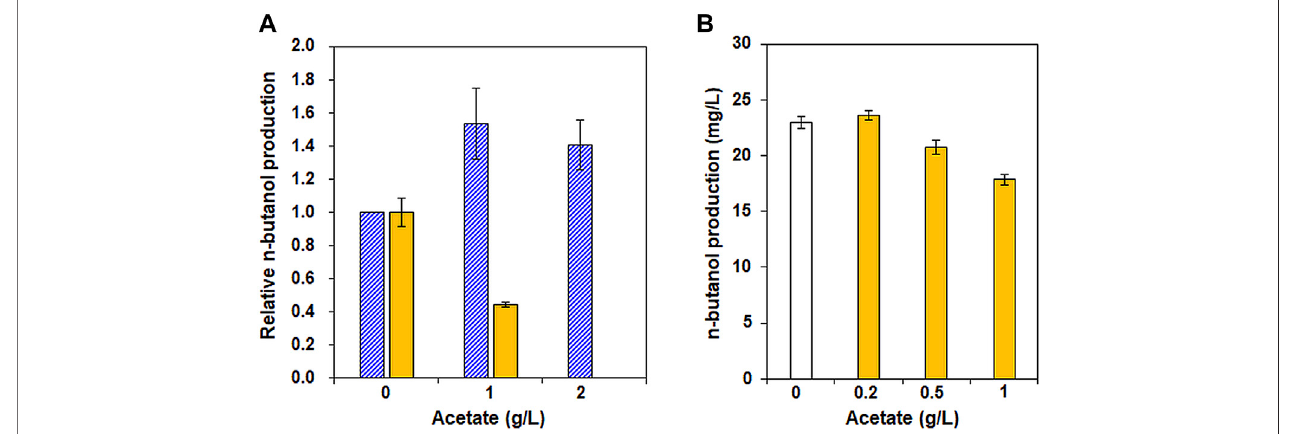
FIGURE 4 | Effect of acetate supplementation on n-butanol production by XUSEA-B strains during glucose and/or xylose fermentation. Fermentation was conducted with an initial OD of 0.2 and various concentrations of acetate (0, 1, or 2 g/L). (A) n-butanol production during glucose (pattern, blue) or xylose (solid, yellow) fermentation. (B) n-butanolproduction during glucose/xylose co-fermentation without (white) and with (yellow) acetatesupplementation (0.2 g/L, 0.5 g/L, or 1 g/L). The error bars represent standard deviations obtained using biological triplicates.